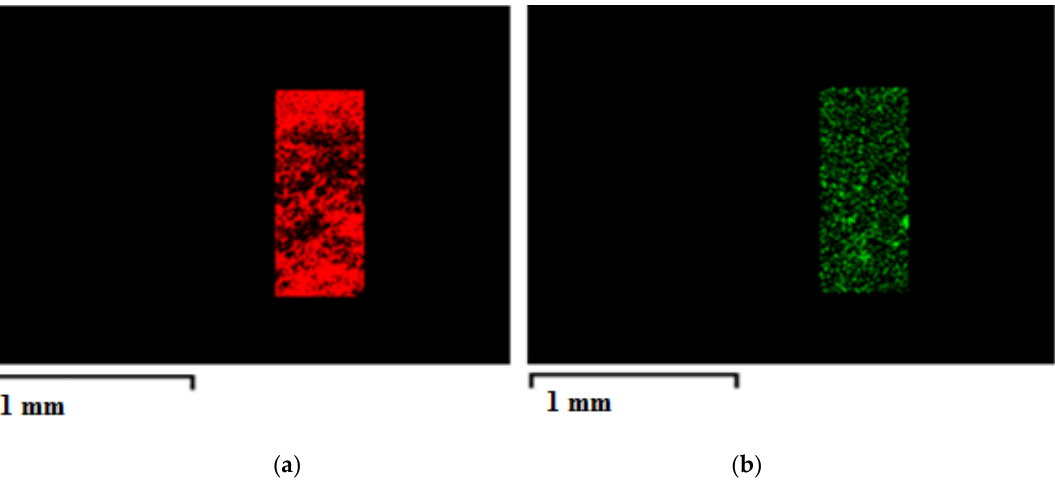
Figure 4. EDX maps of a CA/AgNO3 composite membrane internal section: ( a ) C atoms; ( b ) Ag atoms.